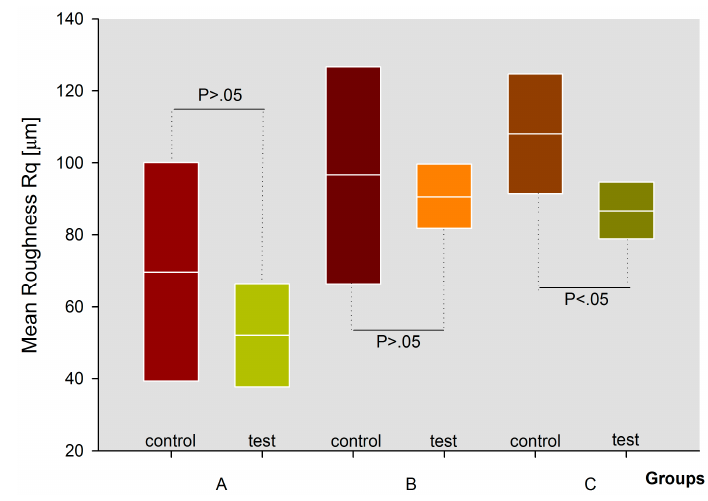
Figure 4. Graphical representation of roughness means of control and test surfaces after treatments with A (glycine), B (erythritol) and C (sodium bicarbonate). The roughness change was significant di ff erent for group C ( p < 0.05).